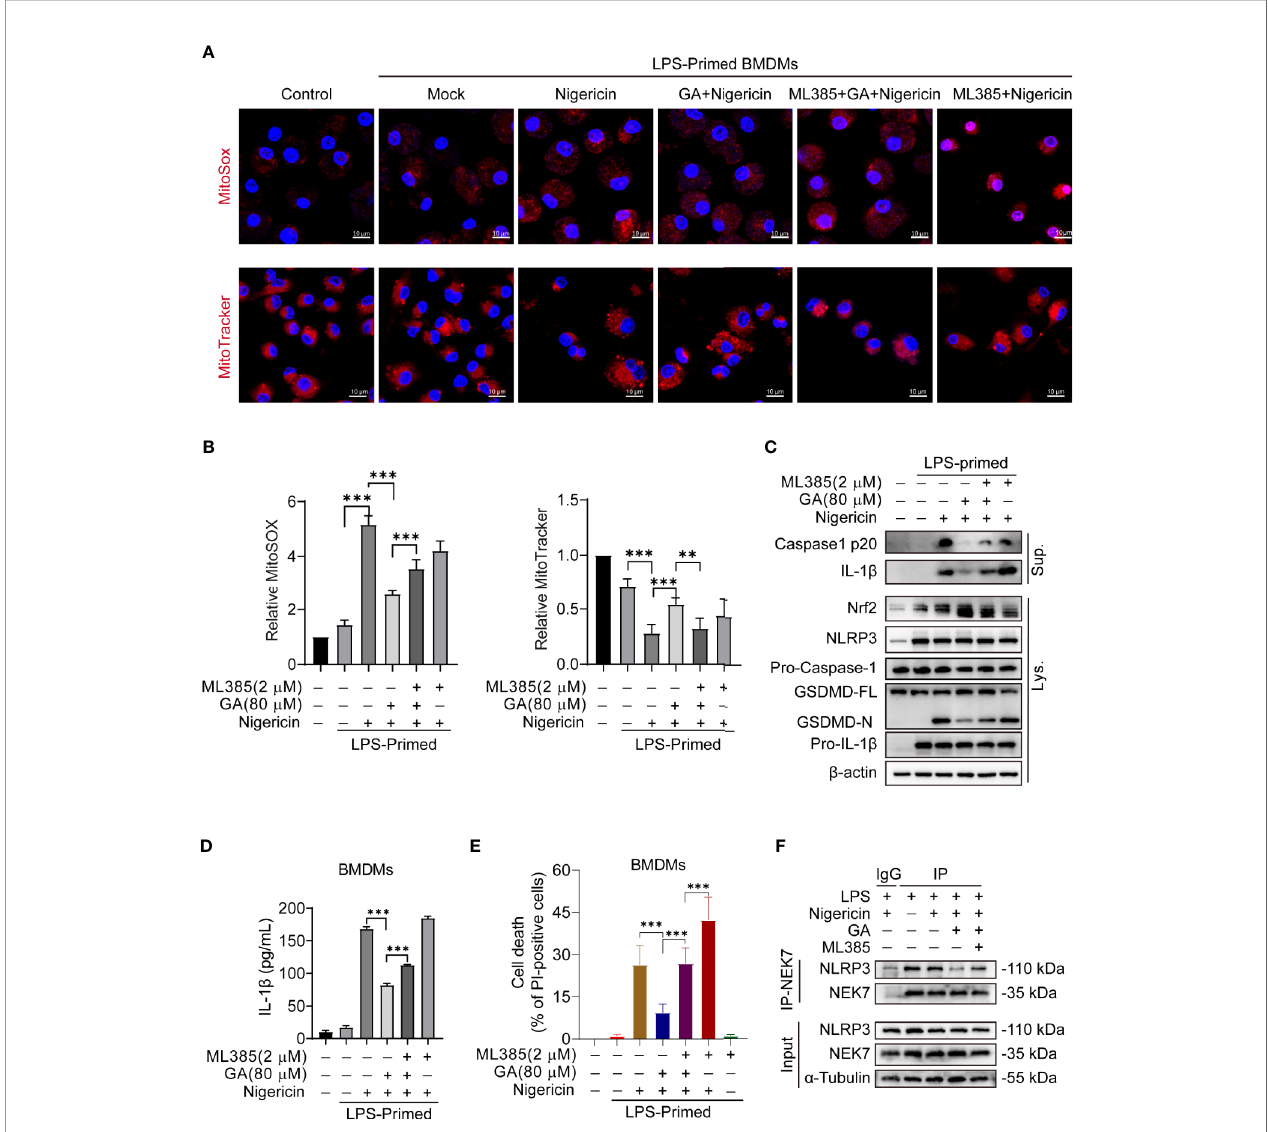
FIGURE 4 | Gallic acid suppresses nigericin-induced NLRP3 in fl ammasome activation and pyroptosis dependent on Nrf2. (A – F) Lipopolysaccharide (LPS)-primed bone marrow-derived macrophages (BMDMs) were incubated with Nrf2 inhibitor ML385 (2 m M) for 30 min, treated with gallic acid (80 m M) for 30 min, and then stimulated with nigericin (10 m M). (A) Representative immuno fl uorescence images of MitoSOX and MitoTracker-stained BMDMs. Scale bars, 10 m m. (B) The relative fl uorescence intensity of MitoSOX and MitoTracker was compared with that of control BMDMs. (E) The percentage of PI-positive cells relative to total cells was calculated; 10 randomly chosen fi elds were quanti fi ed. Data are shown as means ± sem ( n = 10). (C) Supernatants (Sup.) and cell lysates (Lys.) were analyzed by western blotting. (D) ELISA of IL-1 b levels in supernatants. (F) Co-Immunoprecipitation was applied to analyze the interaction between NEK7 and NLRP3. GA, gallic acid. ** P < 0.01, *** P <